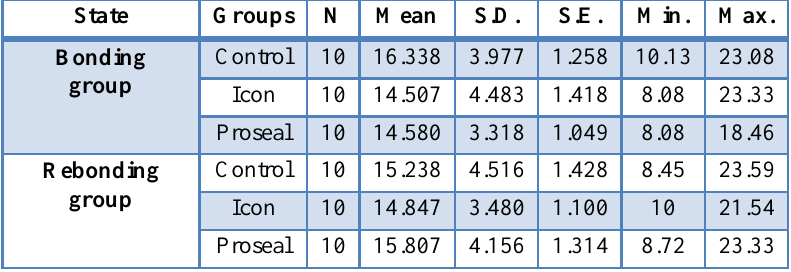
Table 1: Descriptive statistics of the shear bond strength (MPa) of the bonding and rebonding